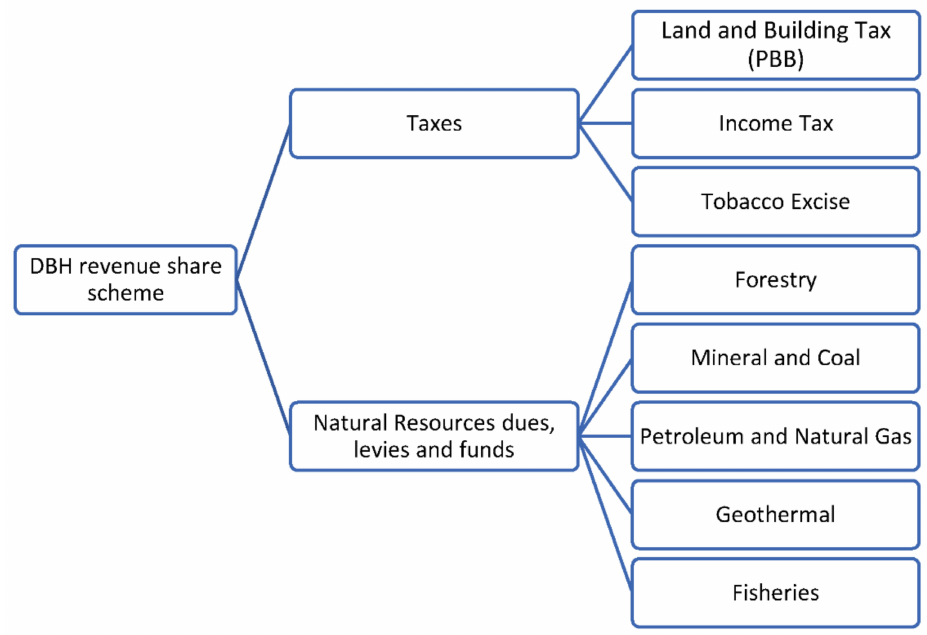
Figure 3. DBH revenue-share scheme and its source of